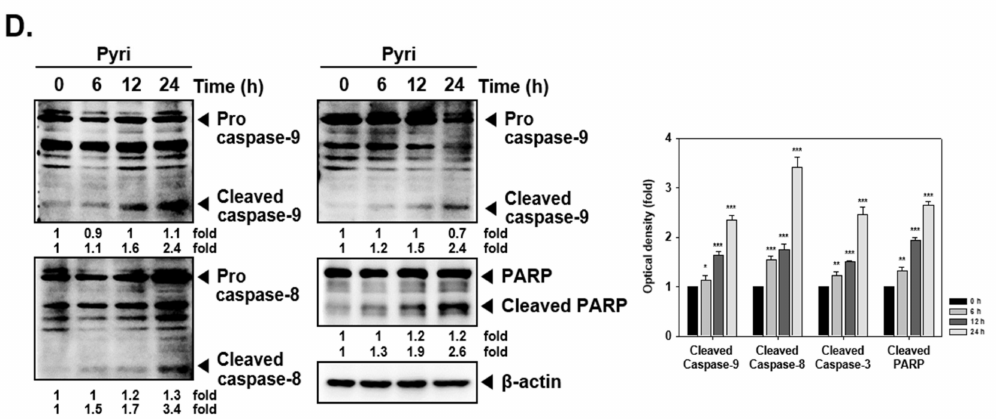
Figure 2. Pyri downregulates the expression of various tumorigenic proteins. ( A ) KBM5 cells (1 × 10 6 cells/well) were treated with 1 µ M of Pyri for indicated time intervals and western blotting was performed ( B ) KBM5 cells were treated with Pyri (1 µ M) as described above and RT-PCR analysis was done. ( C , D ) KBM5 cells were treated with 1 µ M of Pyri for indicated time intervals, and western blotting was carried out. *** p < 0.001 vs. non-treated (NT) cells, ** p < 0.01 vs. non-treated (NT) cells * p < 0.05 vs. non-treated (NT) cells. The results shown are representative of three independent